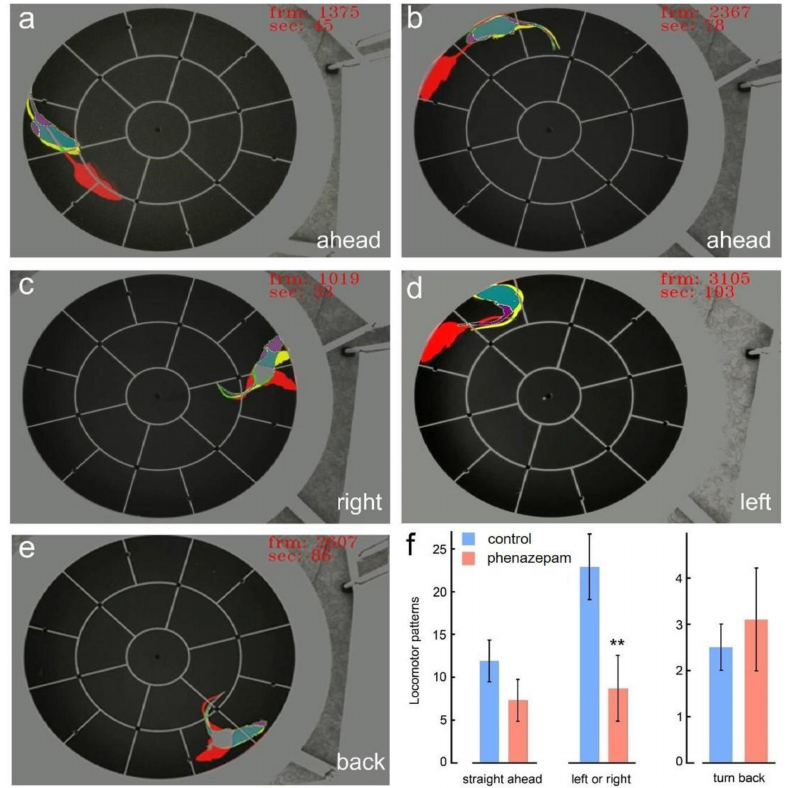
Figure 2. Temporal color-coding of rat locomotion in the open field test in control and phenazepam groups. Initial (present) rat position is represented in magenta, the “near future” position after 1/3 s shown in yellow, the overlap between the present and near future positions shown in dark green, the “far future” location after 5/3 s shown in red, the overlap between near and far future shown in light green, and the overlap of all three positions is shown in gray. Examples of basic locomotor behaviors are presented in panels ( a – e ) as follows: ( a , b ) movement straight ahead, ( c , d ) turns right and left, ( e ) turn back. ( f ) Averaged number of locomotor patterns in the control (blue bars) and phenazepam (red bars) groups as straight ahead, left, turns, middle, turn back, right pair of bars. t -test for the control/phenazepam pairs are as follows: straight, not significant; left or right, **— p < 0.03; back, not significant. Two-way ANOVA with control/phenazepam as factor 1 and the type of locomotion as factor 2 are as follows: factor 1—F = 20.27, p < 0.0001; factor 2—F = 2.08, p < 0.026; interaction—F = 1.13, p < 0.36 (MATLAB